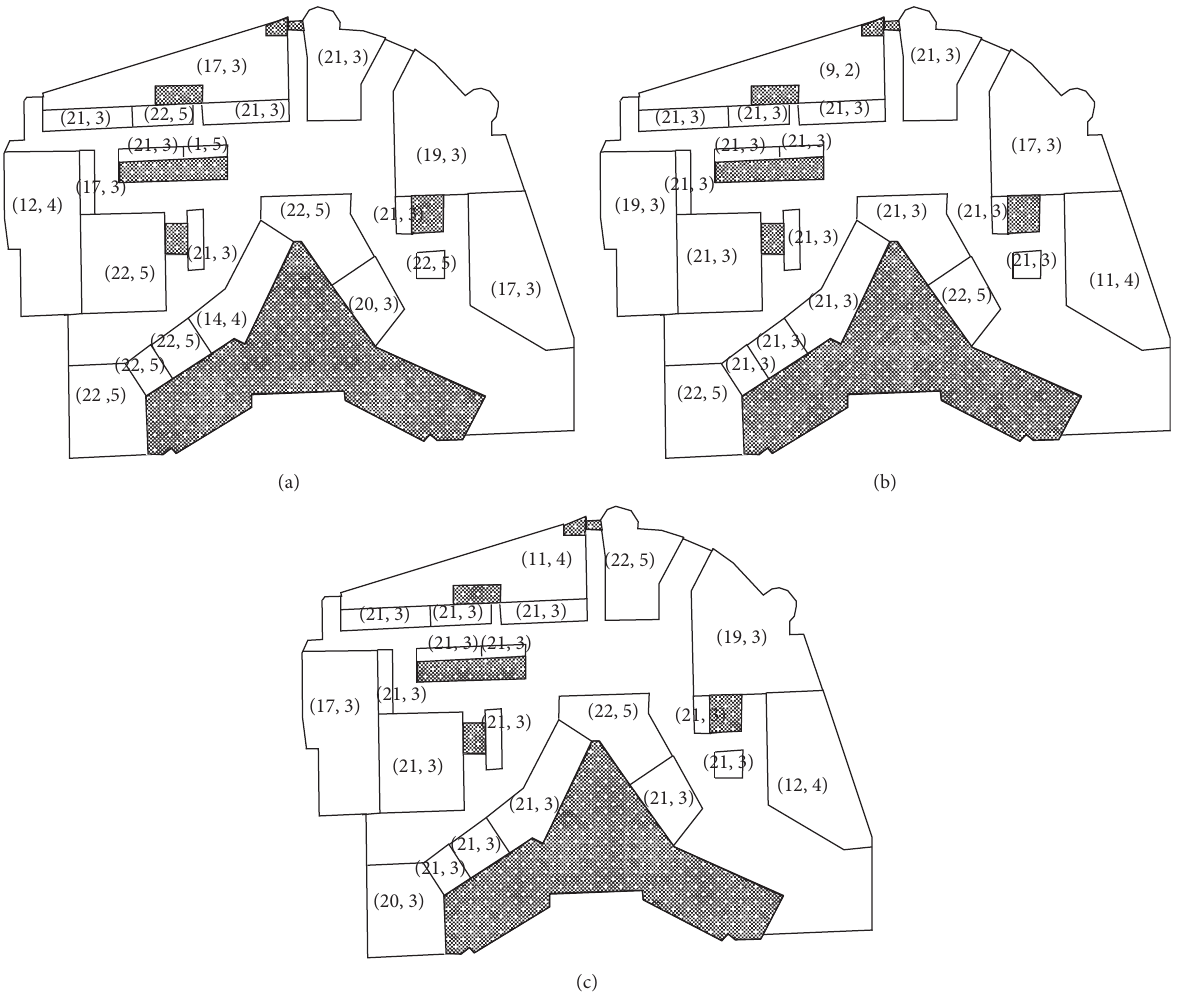
Figure 3: The optimized tenant mix layout. (a) Tenant mix layout, operation 1. (b) Tenant mix layout, operation 2. (c) Tenant mix layout, operation 3. ∗ In ( i , h ), i represents the retail type of the tenant, and h represents the brand level of the store. The shaded area represents the nonrental area.